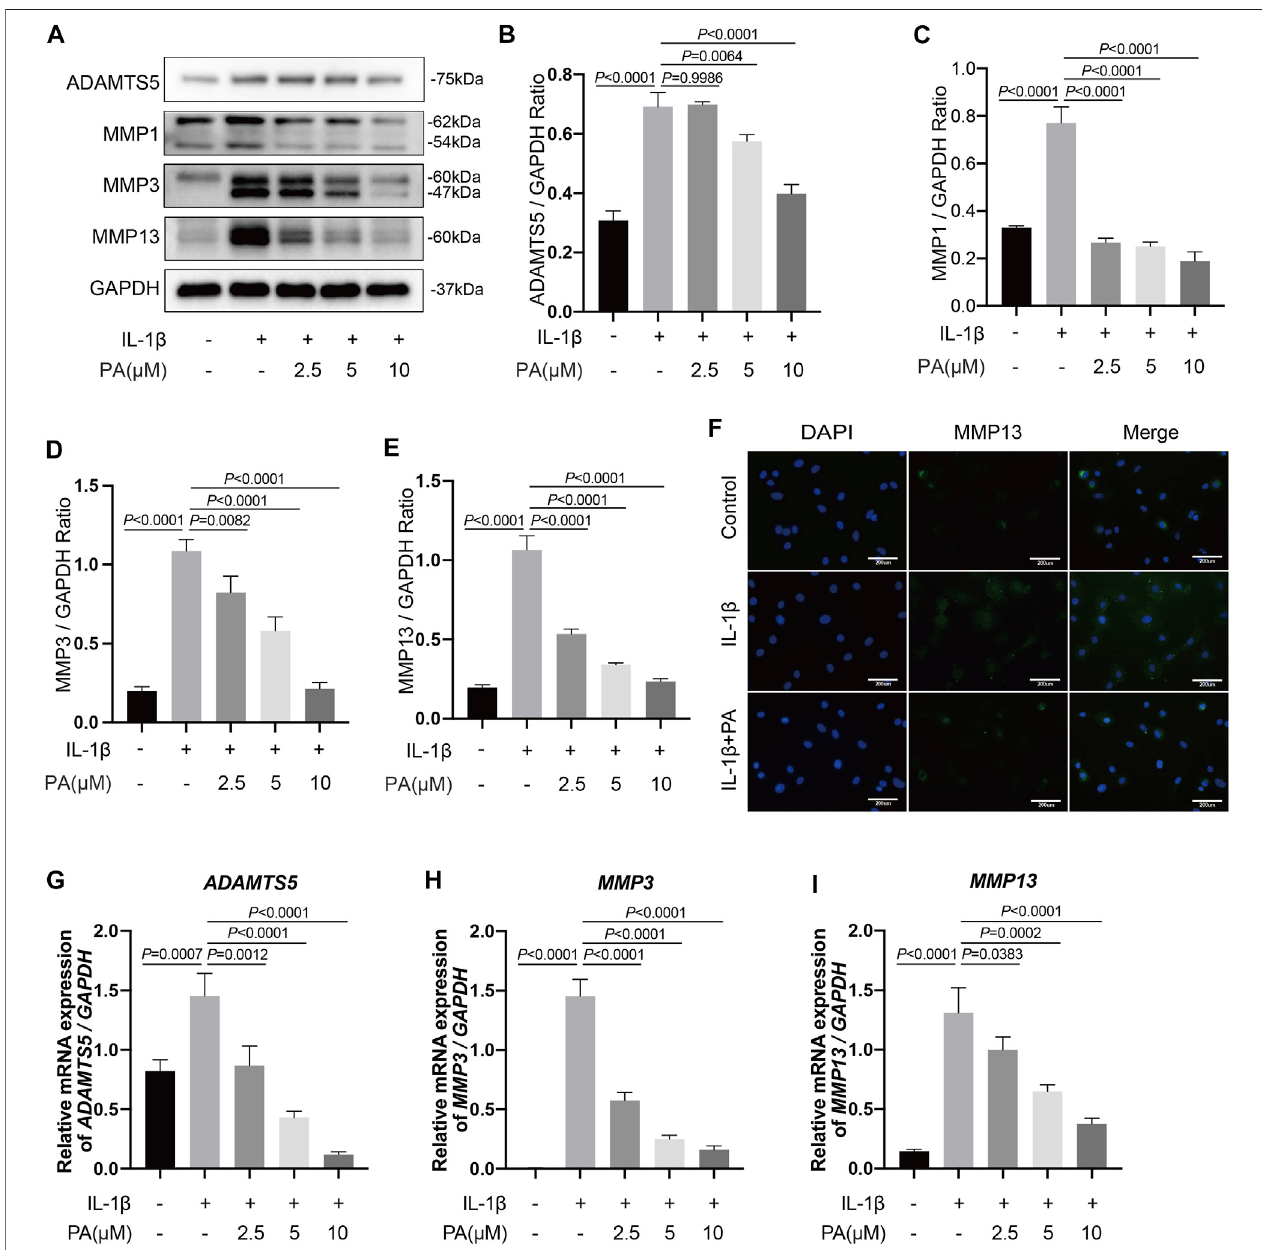
FIGURE 3 | PA suppressed excess expression of the catabolic indicators of chondrocytes induced by IL-1 β , including ADAMTS5, MMP1, MMP3, and MMP13. Mice chondrocytes were treated with 5 ng/ml of IL-1 β , alone or with PA (2.5, 5, and 10 μ M) for 24 h (A) Western blotting results and (B – E) quantitative analysis of ADAMTS5,MMP1,MMP3, andMMP13. (F) MMP13expression wasobservedbyimmuno fl uorescencestainingwhenchondrocytes weretreatedwith5 ng/mlofIL-1 β , alone or with 10 μ M of PA (scale bar 200 μ m). (G – I) Relative mRNA levels of ADAMTS5, MMP3, and MMP13 in chondrocytes stimulated with 5 ng/ml of IL-1 β , aloneorwithPA(2.5,5,and10 μ M)for24 h.GAPDHwasused asaninternalreference.Dataarepresented asmeans ± SD( n (cid:1) 3). Theexact p valuewasmarkedinthe corresponding fi gure and p < 0.05 was considered statistically signi fi